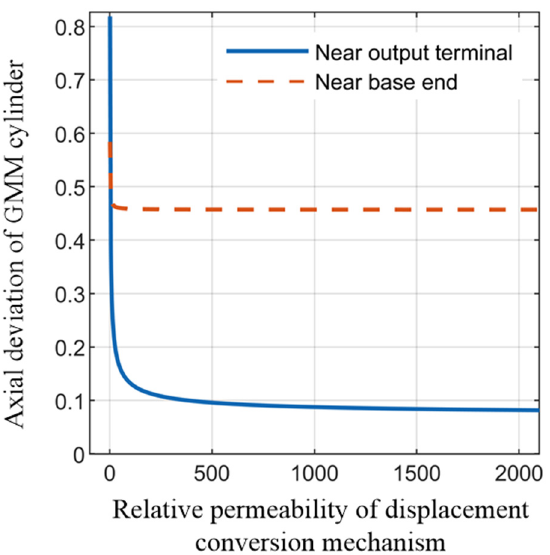
Figure 15. Influence of relative permeability of shell on deviation of axial magnetic density of GMM cylinder.